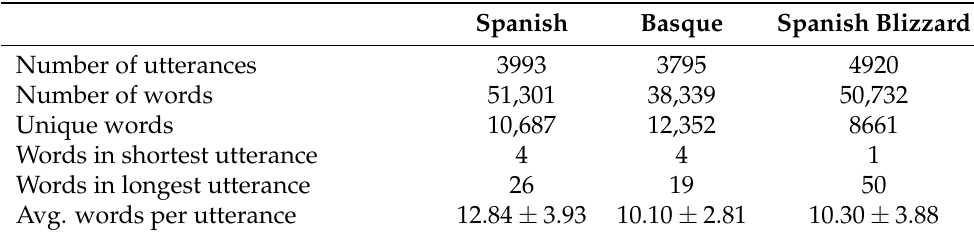
Figure 1. Distribution of words per utterance in the training dataset. Table 1. Description of the training